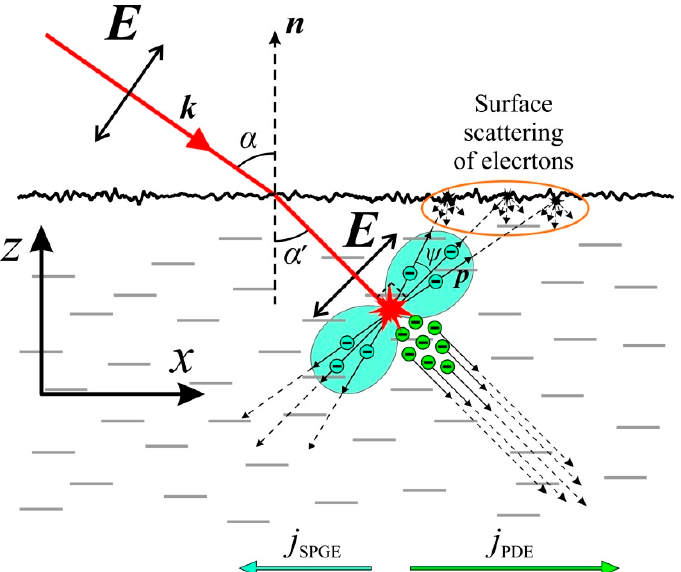
Figure 1. Schematic illustration of SPGE and PDE at the p -polarized excitation. The plane of incidence coincides with the ( xz ) plane of the laboratory Cartesian frame. The probability of the photoexcitation of charge is proportional to cos 2 ( ψ ), where ψ is the angle between the electric field E and the electron quasimomentum p . The momenta of photoexcited electrons become unbalanced because the electrons moving toward the surface lose momentum faster than those moving outwards. The PDE photocurrent arises due to free electrons in the sample getting momentum from photons. ( Reprinted from [14]).